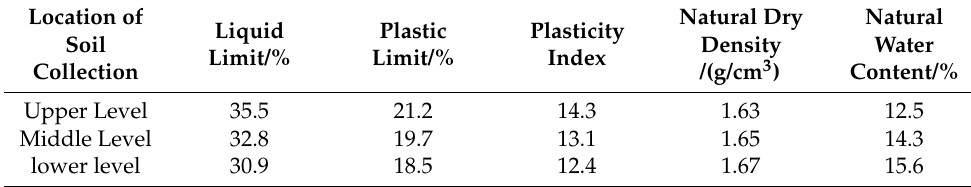
Table 1. Basic properties of soil samples from the Zhouqiao site.